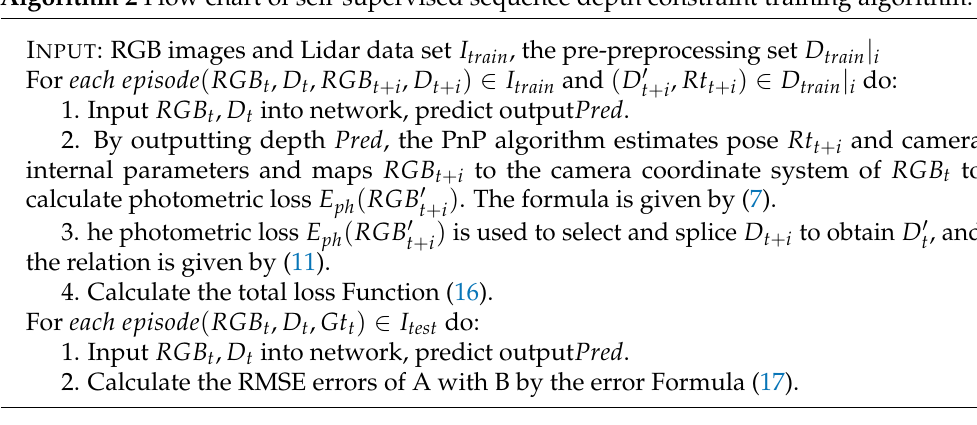
Algorithm 2 Flow chart of self-supervised sequence depth constraint training